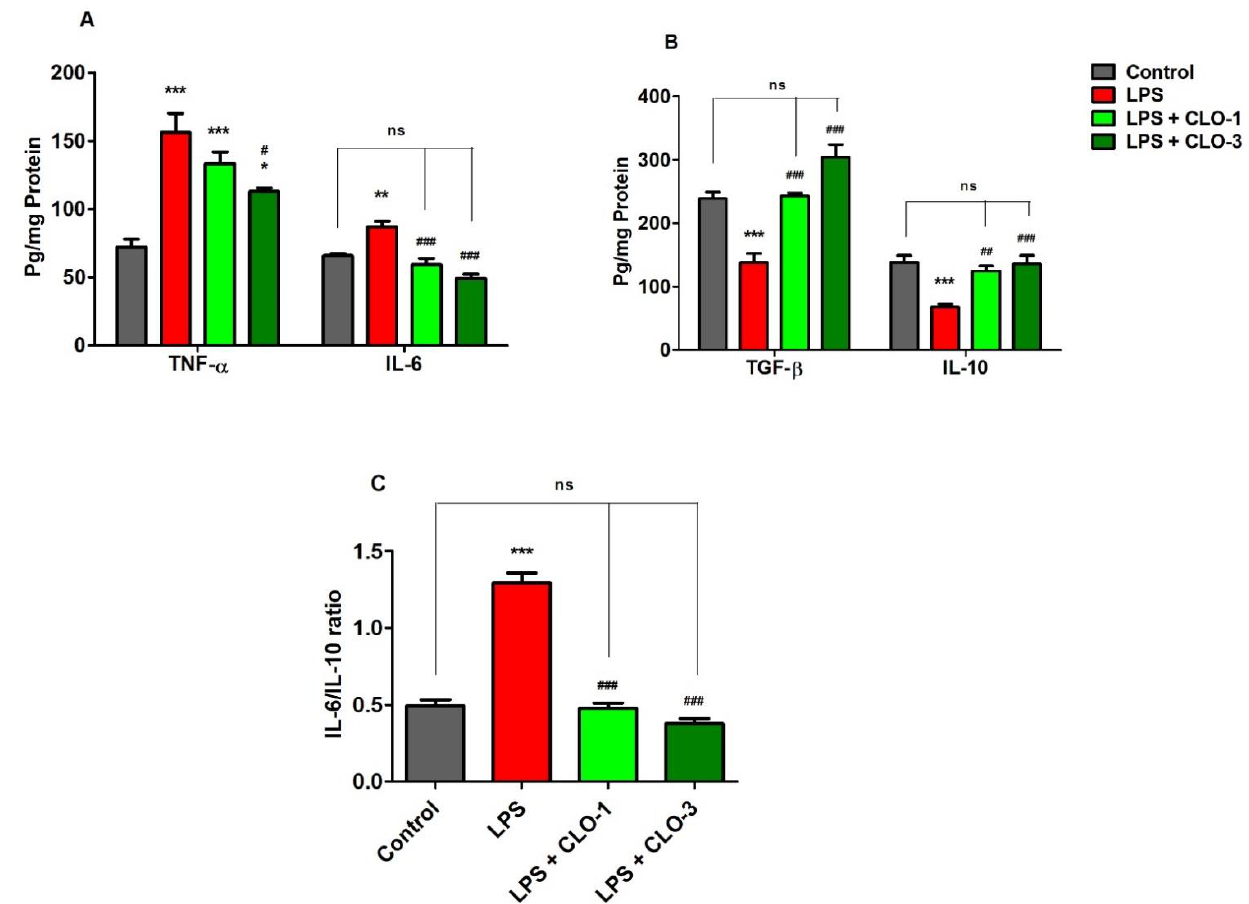
Figure 3. Effect of clobenpropit (CLO) on ( A ) pro-inflammatory cytokines (TNF- α and IL-6), ( B ) anti-inflammatory cytokines (TGF- β and IL-10), and ( C ) IL-6/IL-10 ratio in lipopolysaccharide (LPS)-induced mice brains. LPS-CLO-1 and LPS-CLO-3 refer to the administration of clobenpropit (1 or 3 mg/kg, p.o, respectively) and lipopolysaccharides (250 µ g/kg, i.p.). Administration of LPS resulted in the elevation of pro-inflammatory cytokines and reduction of anti-inflammatory cytokine activities. Interestingly, the CLO treatment attenuated the inflammatory activity of LPS. The ratio of IL-6/IL-10 also lowered with CLO treatment in LPS-challenged mice. The results are expressed as mean ± SEM ( n = 6). One-way ANOVA ( F (3,20) = 16.68, p < 0.001 for TNF- α and F (3,20) = 20.96, p < 0.001 for IL-6) ( F (3,20) = 26.33, p < 0.001 for TGF- β and F (3,20) = 11.18, p < 0.001 for IL-10) ( F (3,20) = 88.18, p < 0.001 for IL-6/IL-10 ratio) was followed by Tukey – Kramer multiple comparisons tests. * p < 0.05, ** p < 0.01 and *** p < 0.001 as compared to the control group; ns, not significant as compared to the control group; # p < 0.05, ## p < 0.01 and ### p < 0.001 as compared to the LPS-treated group.